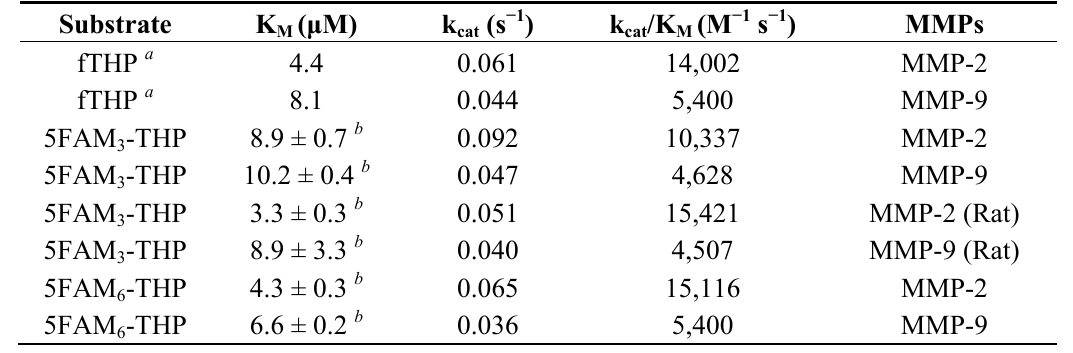
Table 1. Enzyme kinetic parameters for gelatinase mediated hydrolysis of 5FAM-THPs.